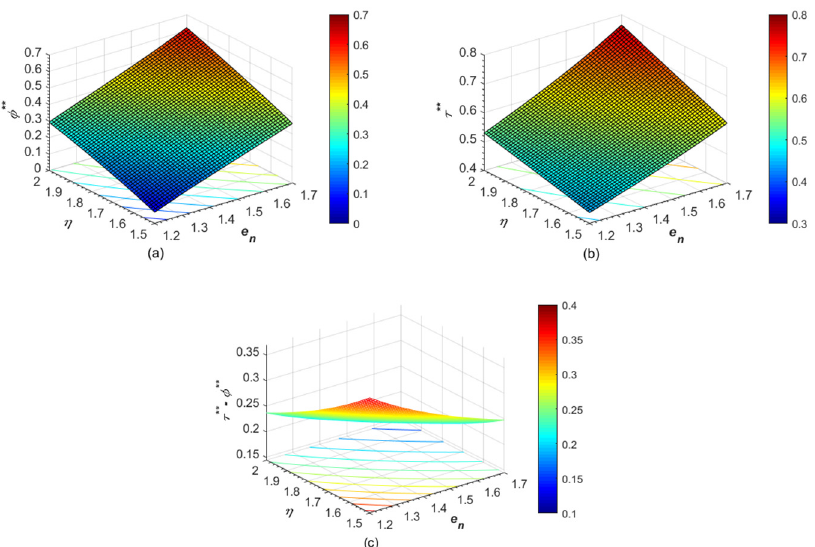
Figure 3. Effects of e n and η on ( a ) optimal pre-determined abatement target φ **, ( b ) carbon abatement investment level τ **, and ( c ) excessive abatement level τ ** − φ **.